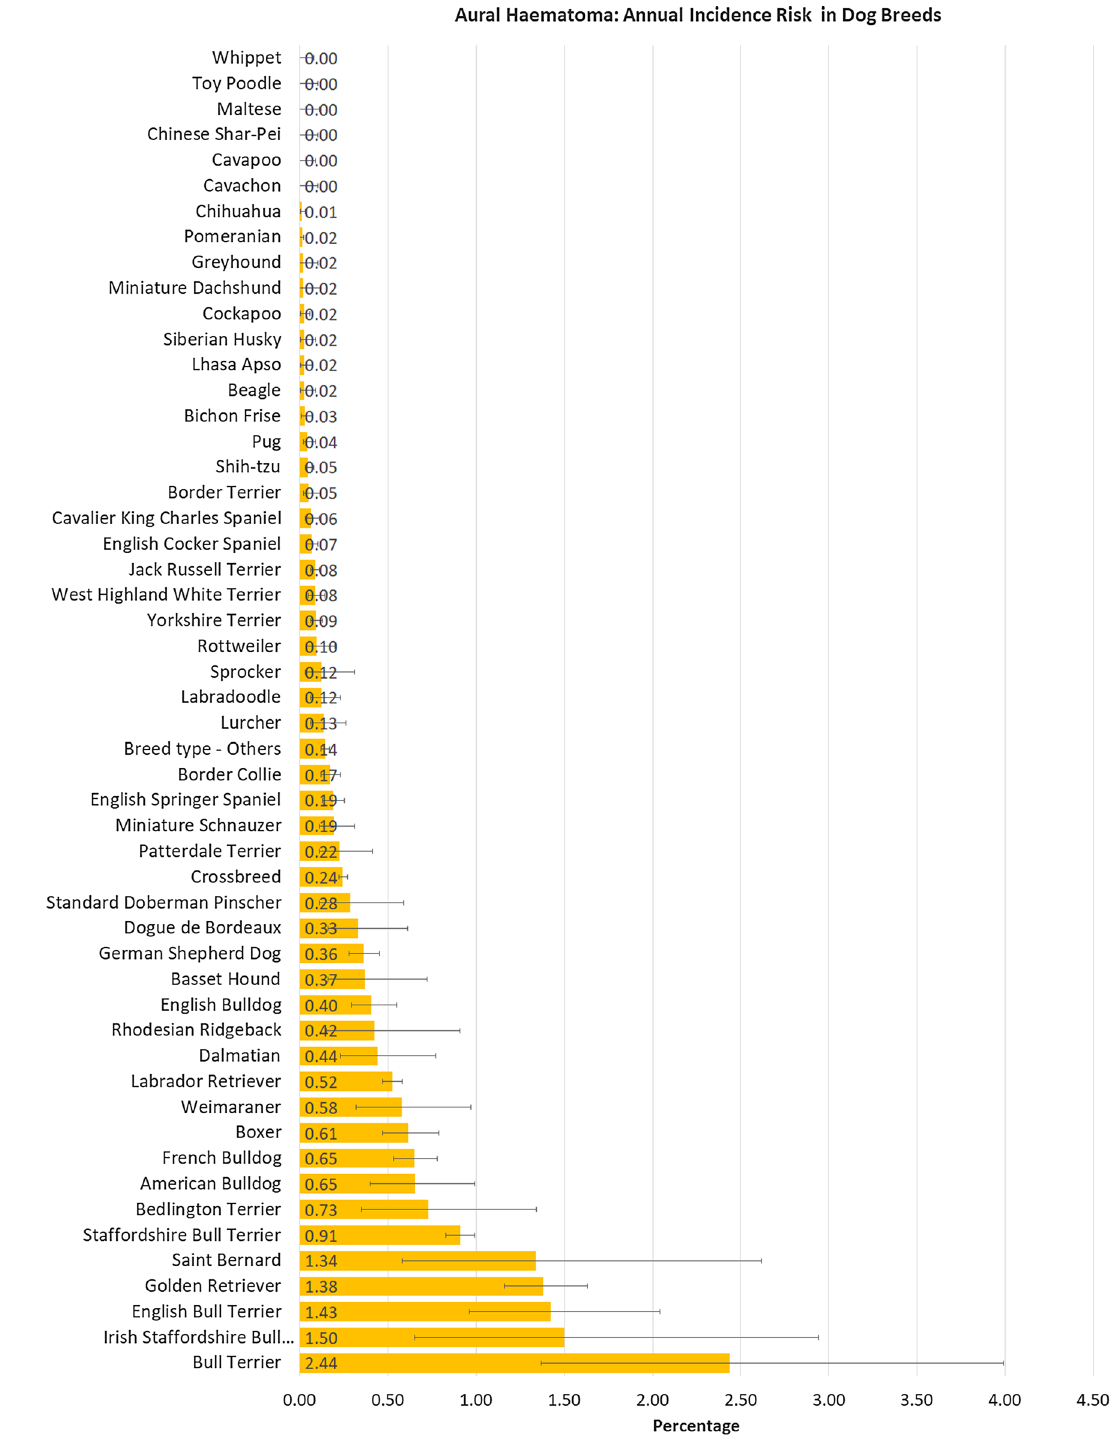
Figure 1. One-year (2016) incidence risk (percentage) for aural haematoma in dog breeds under primary veterinary care in the VetCompass™ Programme in the UK. The horizontal bars represent 95% confidence